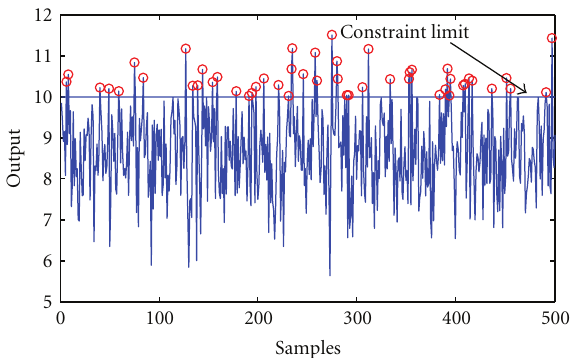
Figure 8: Improved case, optimal operation with probability constraint level of 90%.